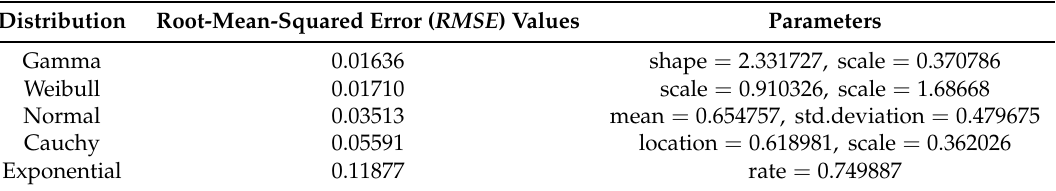
Table 1. Fitting a distribution by using particle-swarm optimization—experiment results.